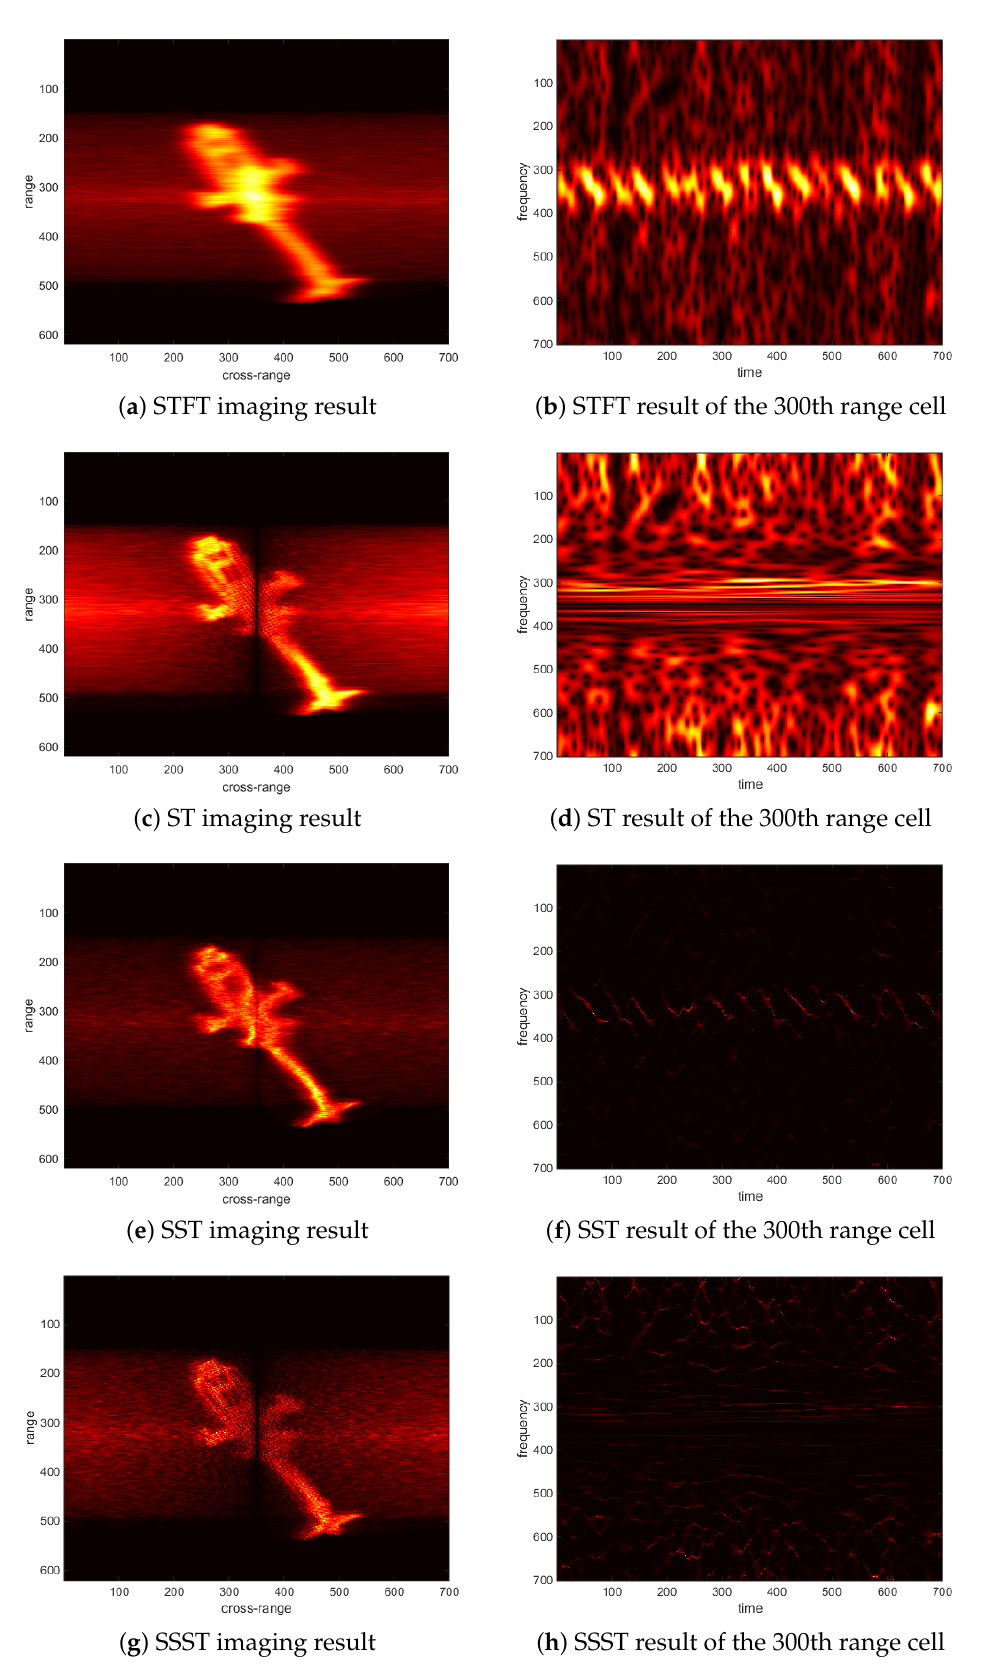
Figure 4. Results of target with a main rotor speed of 5 r/s. ST—S-transform; SST—synchrosqueezing transform; SSST—synchrosqueezing S-transform; STFT—short time Fourier